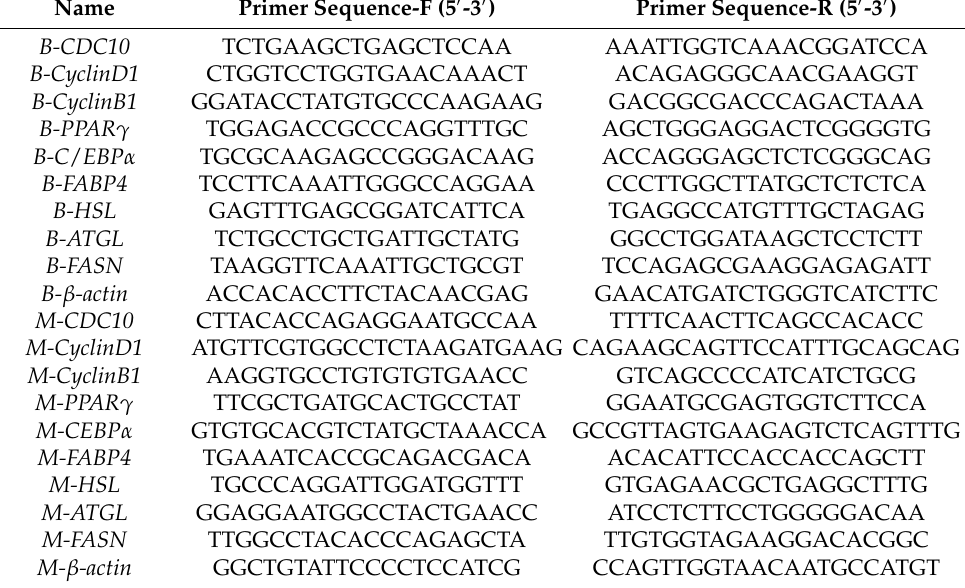
Table 2. Primers for real-time